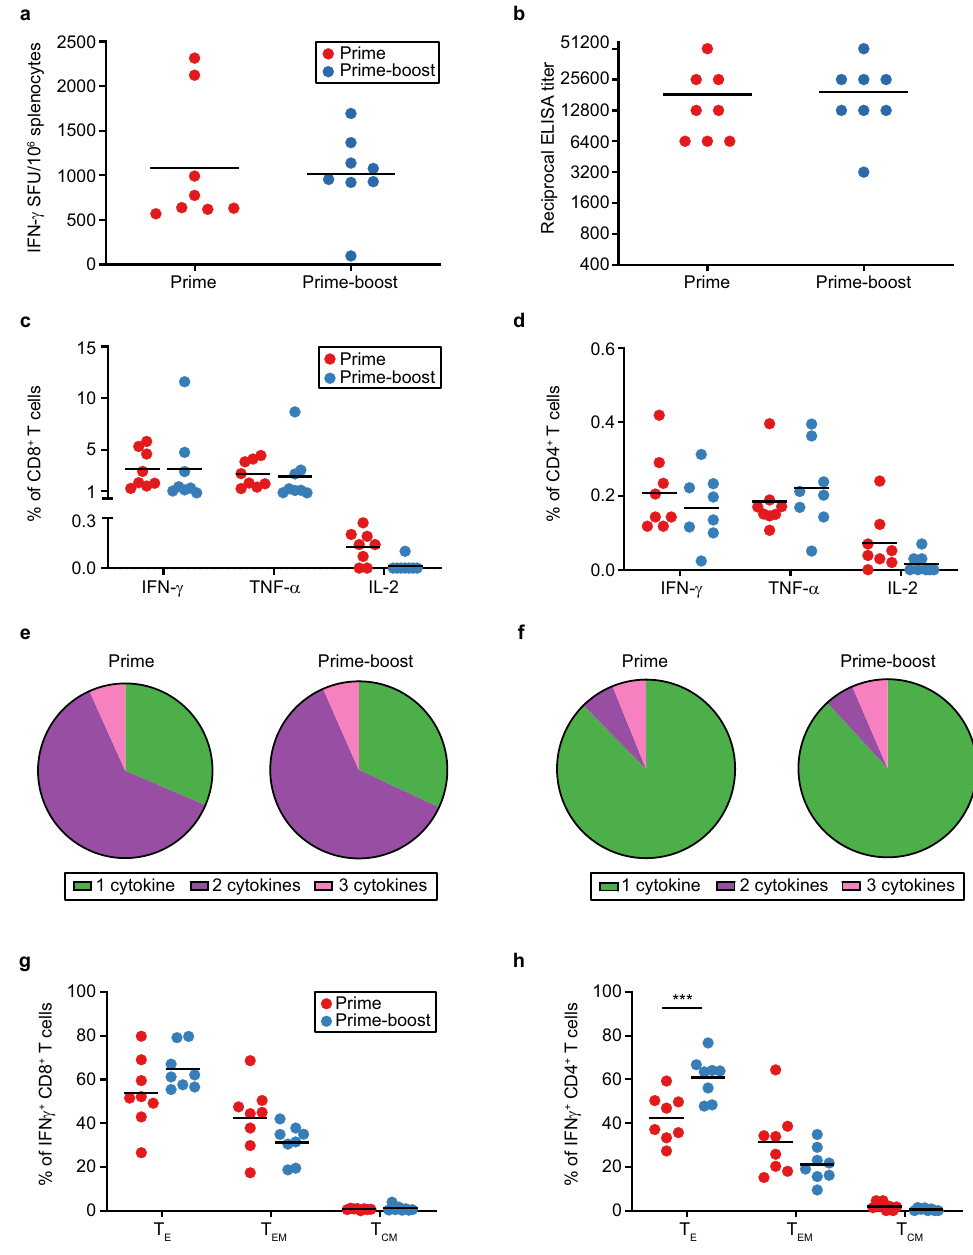
Fig. 1 ChAdOx1-Lassa-GPC vaccination elicits a potent cellular and humoral immune response in mice. CD-1 mice received prime ( n = 8) or prime-boost ( n = 8) vaccination with ChAdOx1-Lassa-GPC. Spleen and serum samples were collected three weeks after the fi nal immunization. a IFN- γ ELISpot of murine splenocytes measured in spot forming units (SFU) per 1.0 × 10 6 splenocytes. The magnitudes of the prime and prime-boost responses were determined to be statistically similar by an unpaired t -test. b LASV GP-speci fi c IgG antibody titers in twofold serial-diluted sera were measured by ELISA and were statistically similar according to Mann – Whitney test. The percentage of CD8 + ( c ) and CD4 + ( d ) T cells expressing IFN- γ , TNF- α , or IL-2 after GPC peptide pool stimulation was determined by intracellular cytokine staining of splenocytes. Graphed values re fl ect adjustment to exclude non-speci fi c cytokine expression as measured from a corresponding set of unstimulated samples. All statistical comparisons between the prime and prime-boost vaccinates were not signi fi cant by two-way ANOVA with Sidak ’ s multiple comparisons test. The proportion of cytokine-secreting (IFN- γ + , TNF- α + , or IL-2 + ) CD8 + ( e ) and CD4 + ( f ) T cells expressing only one or multiple cytokines. Percentages of LASV-speci fi c (IFN- γ + ) CD8 + ( g ) and CD4 + ( h ) T cells exhibiting T E , T EM , and T CM phenotypes as determined by immunostaining for CD44, CD62L, and CD127 surface markers. Phenotypic differences in the T-cell responses of the prime and prime-boost groups were not statistically signi fi cant by two-way ANOVA with Sidak ’ s multiple comparisons test, except for the increase in the CD4 + T E subset post boost (*** p =